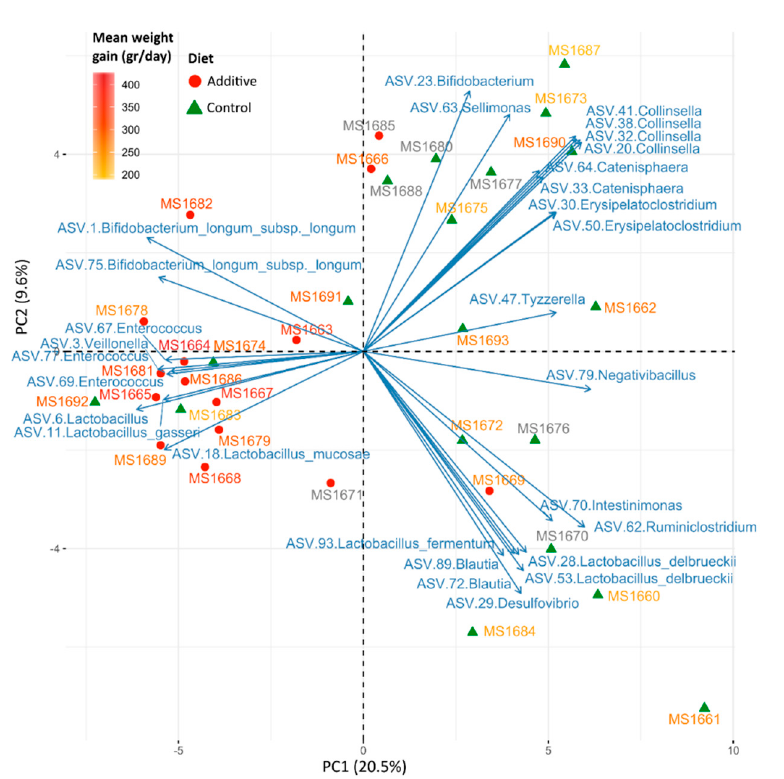
Figure 6. Principal Component Analysis (PCA) of the 100 most abundant ASVs in lamb feces. Sample dots are colored and shaped according to each lamb’s diet (red circles or green triangles for additive or control diets, respectively) and sample names are colored regarding the mean daily weight gain of that lamb (from yellow, lower, to red, higher). Grey names represent those samples in which the mean daily weight data is missing. The 30 ASVs that contributed mainly to the separation of the samples in the analysis are represented as blue arrows heading those samples where they were especially abundant.